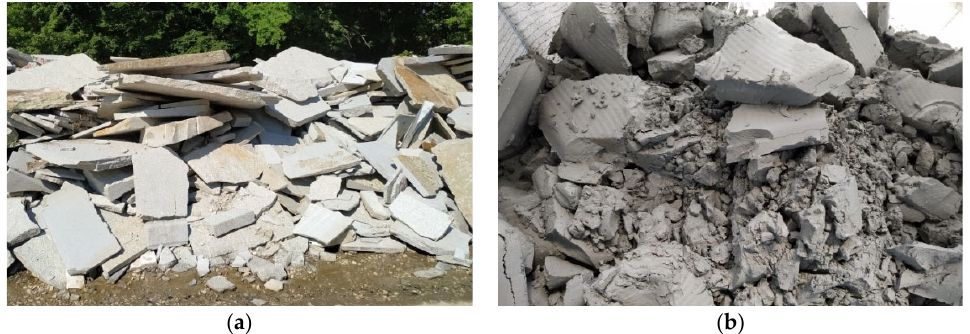
Figure 1. Stone waste: ( a ) crushed slabs (different waste size); ( b ) sludge. Solid scraps are produced in the process of cutting off larger parts of natural stone or giving the texture of stone surfaces without the use of water. Solid scraps have various sizes, from a few millimetres to several hundred centimetres [4]. The most common type of solid scrap includes offcuts, i.e., rough-edged stone cut off the stone block in order to achieve regular surfaces of the stone block (Figure 3). The length and width of the offcuts are usually equal to the size of the stone block being worked on (e.g., 2.5 × 1.5 m). However, the thickness of this waste is from several to several dozen cm. It should be noted that the sizes of these scraps depend on the quality of the processed stone block (regular and equal shape of the stone block), which is influenced by the adopted mining technology. Therefore, a properly selected dimension stone mining technology may significantly reduce the size of the produced stone